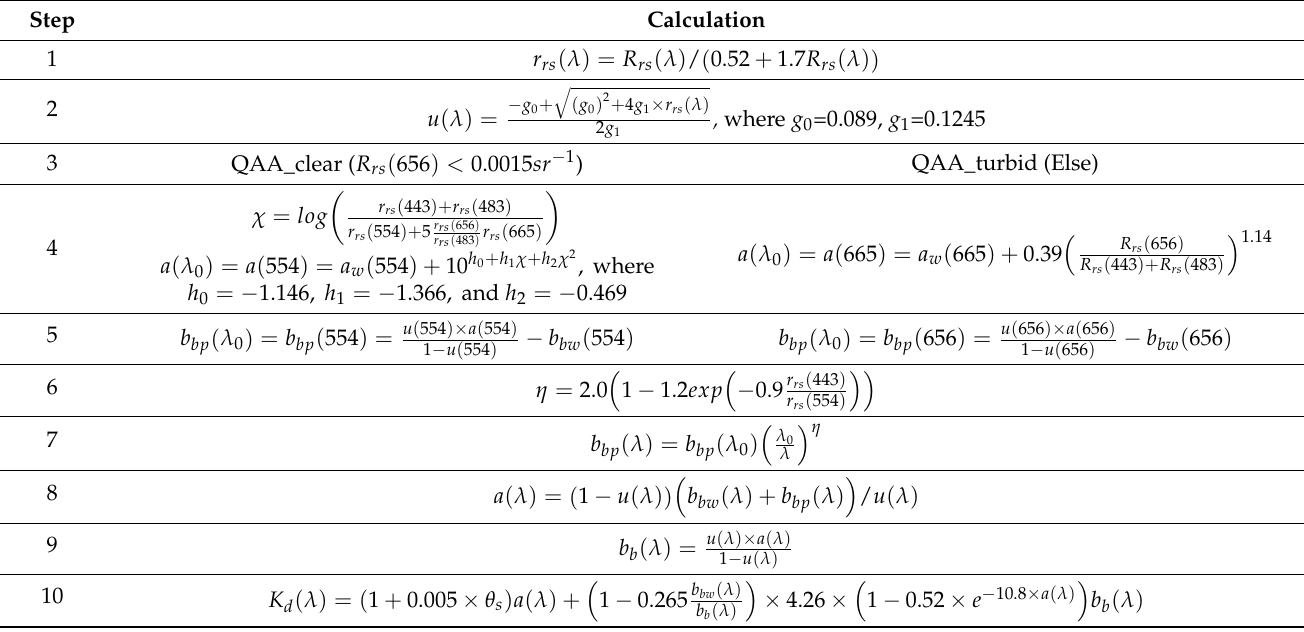
Table 2. Steps of QAA_v6 for Landsat